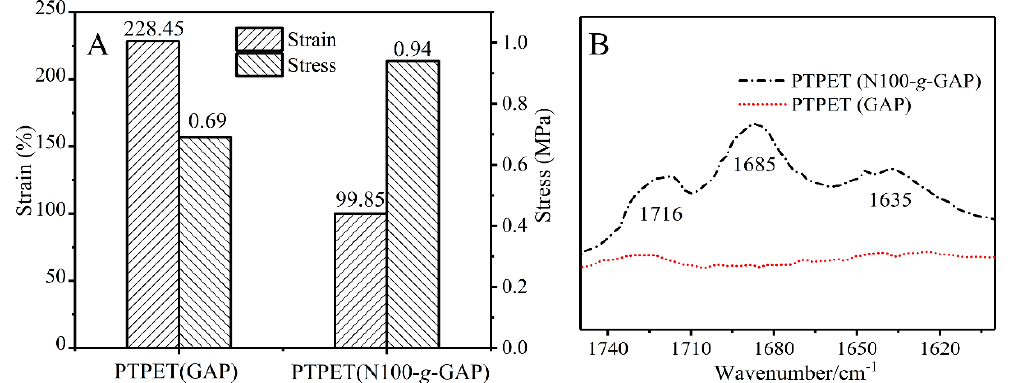
Figure 5. ( A ) Stress–strain curves of the PTPET elastomer prepared by N100- g -GAP and GAP ( Mn = 4000 g/mol) at 20 °C; ( B ) Infrared analysis of two samples.